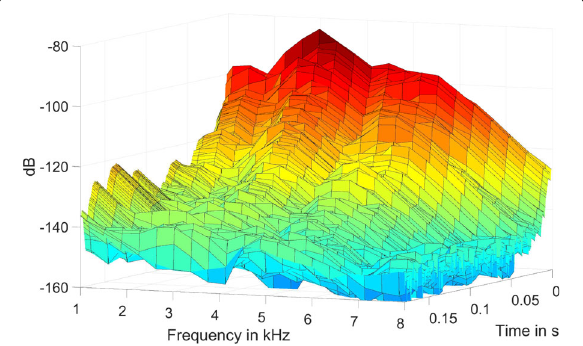
Fig. 8 Cumulative spectral decay of the full-face mask with activated communication